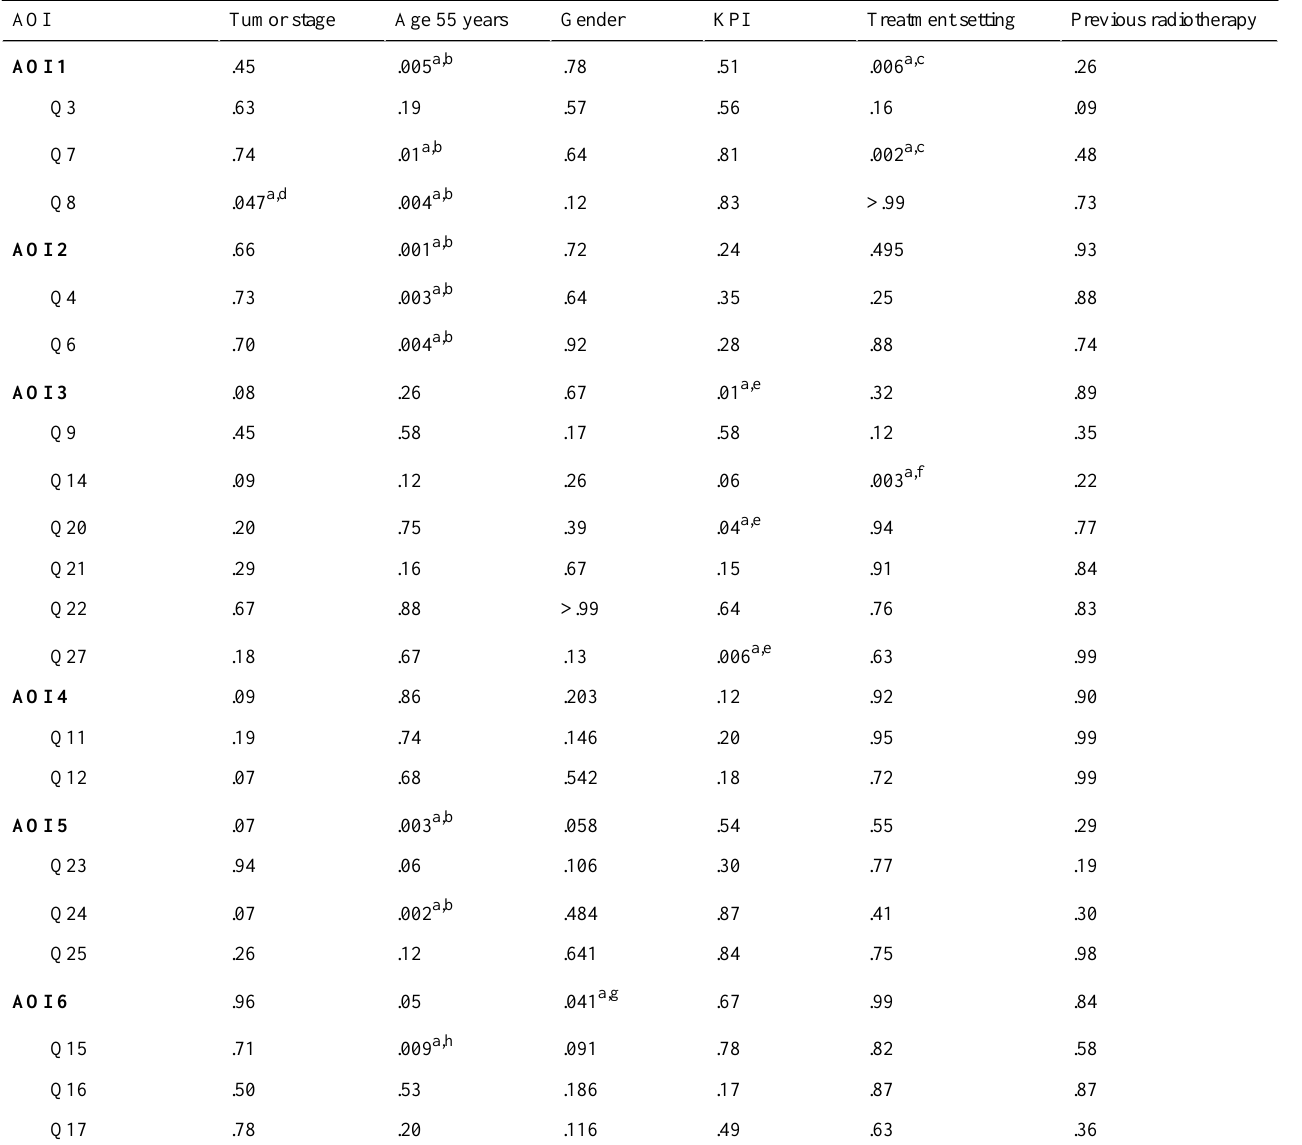
Table 4. P values for the influence of tumor stage, age, gender, initial Karnofsky performance scale index (KPI), treatment setting (curative vs palliative), and previous radiotherapy on the answers provided to the survey items and area of interest (AOI)